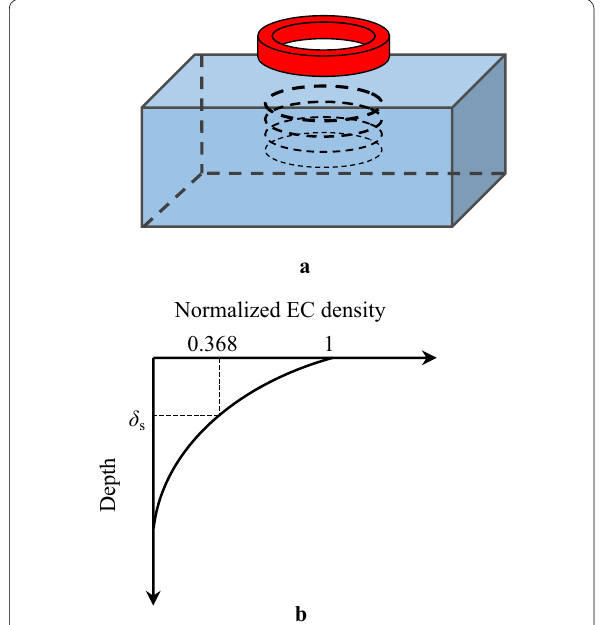
Figure 1 Illustrations of skin effect and skin depth: a skin effect; b skin depth